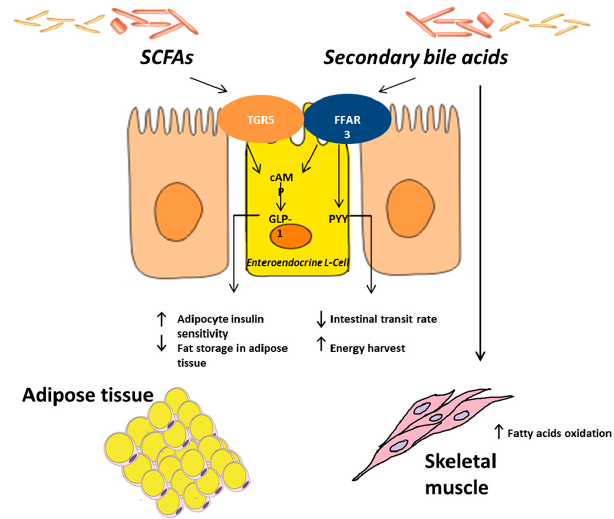
Figure 1. Gut microbiota and energy balance. The gut microbes can benefit the host by extracting energies from otherwise non-digestible carbohydrates and plant polysaccharides via enzymes not encoded by humans. Short-chain fatty acids (SCFAs) modulate intestinal gluconeogenesis via the gut-brain neuronal circuit, involving GPR41 (free fatty acid receptor, FFAR3) and through the cyclic adenosine monophosphate (cAMP)-dependent pathway. Butyrate is able to regulate the appetite in the central nervous system by stimulating the liberation of peptide YY (PYY) and the satietogenic hormone glucagon-like peptide 1 (GLP-1) from enteroendocrine L-cells. PYY decreases the intestinal transit rate and increases the harvest of energy from the diet, while GLP-1 improves adipocyte insulin sensitivity and remarkably reduces fat storage in adipose tissue. Gut microbes can also control the metabolic activity of the host by affecting the composition and the abundance of certain bile acid species. In the ileum microbes deconjugate cholic and chenodeoxycholic acids, which escape intestinal uptake, and are converted into secondary bile acids. Bile acids can also act as signaling molecules by binding cellular receptors such as the bile-acid-synthesis controlling nuclear receptor farnesoid X receptor (FXR), G-protein-coupled receptors (GPCR), and TGR5. While primary bile acids can impair glucose metabolism by binding FXR, secondary bile acids, by binding TGR5, improve glucose homeostasis and increase energy expenditure in skeletal